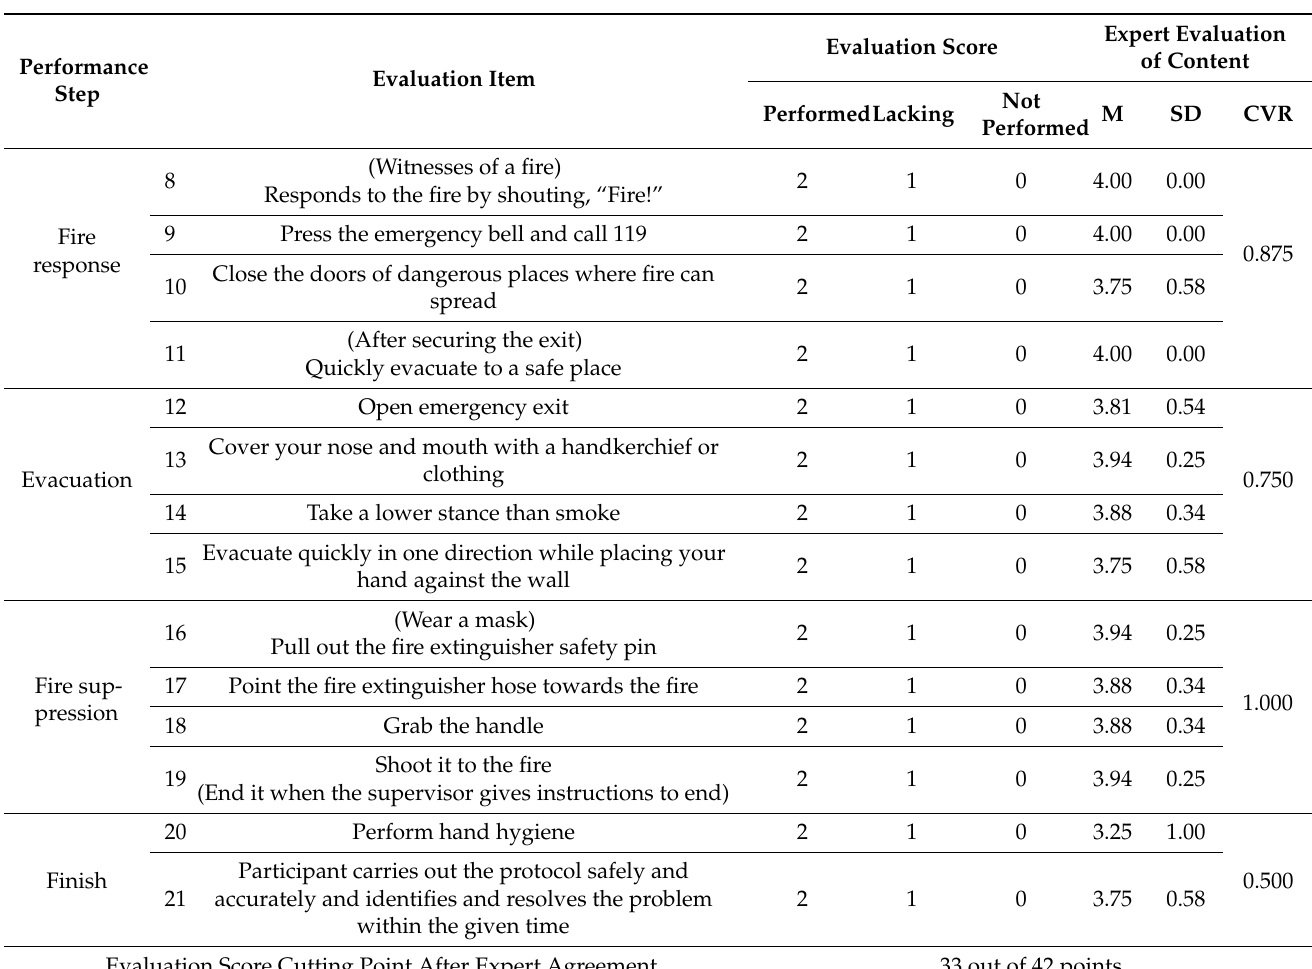
Table 2. Evaluation